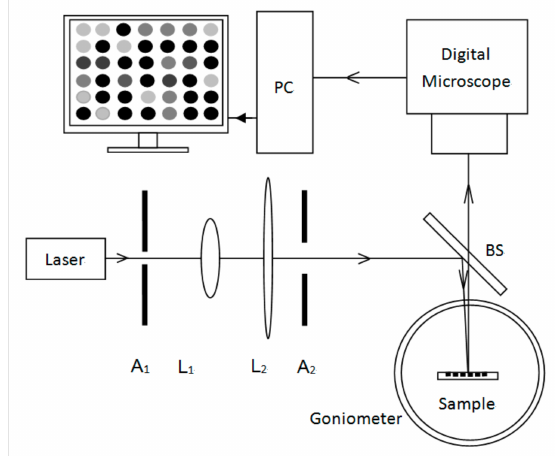
Figure 11. Gray value detection system based on PSM / PSM microarray surface